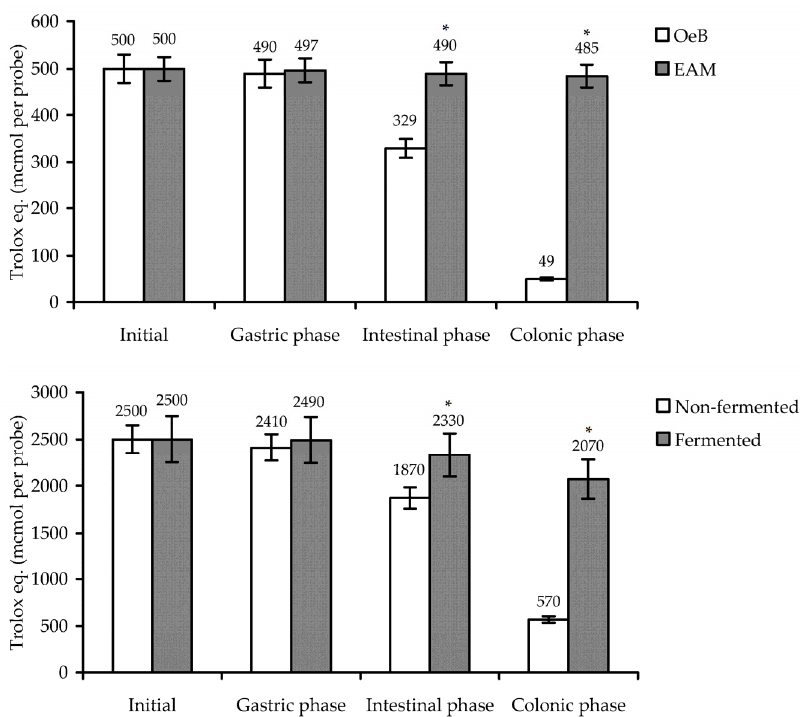
Figure 9. The trolox-equivalent content in oenothein B and E. angustifolium melanoidin (EAM) solutions, and E. angustifolium decoctions (non-fermented and fermented samples) after in vitro treatment by the simulated gastric medium (gastric phase), intestinal medium (intestinal phase) and after 72 h incubation with gut microbiota (colonic phase). * p < 0.05 vs. non-fermented group.